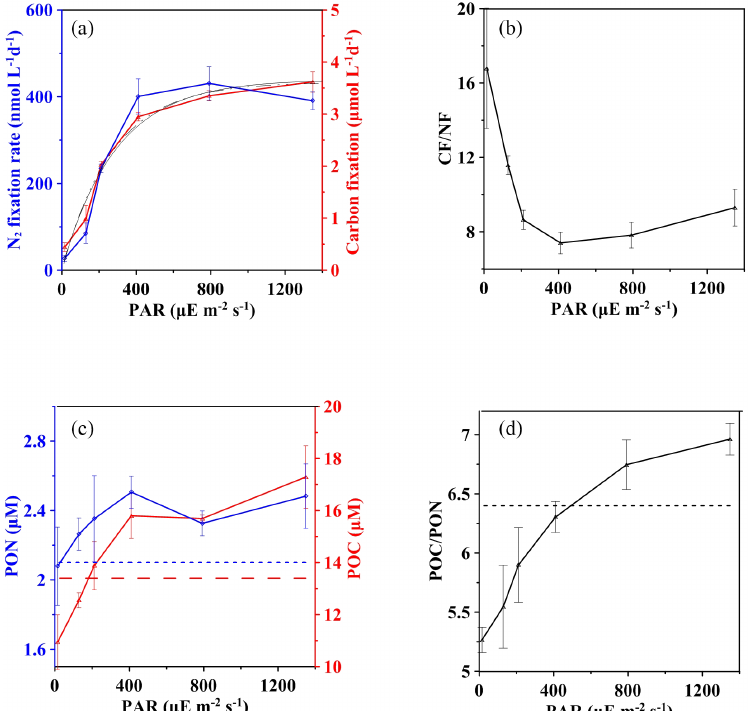
Figure 4. Effect of light on the carbon and nitrogen budget at station S0320 with a Trichodesmium thiebautii bloom. (a) Carbon (red solid line) and nitrogen (blue solid line) fixation at different light intensities with fitted light response curves (black solid line for CF and black dotted line for NF). (b) The CF / NF ratios at different light intensities. (c) The final concentrations of POC (red solid line) and PON (blue solid line) after incubations under different light intensities and initial values of POC (red dashed line) and PON (blue dashed line) concentration. (d) C / N ratios after incubation in different light conditions. Error bars represent the standard deviation of